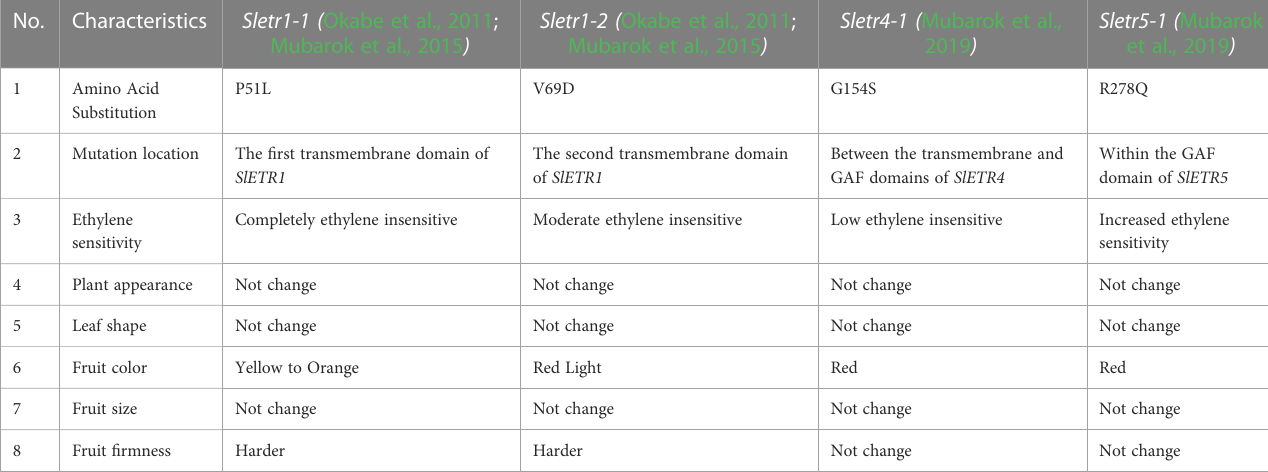
TABLE 1 The differences between four ethylene receptor mutants of tomato.